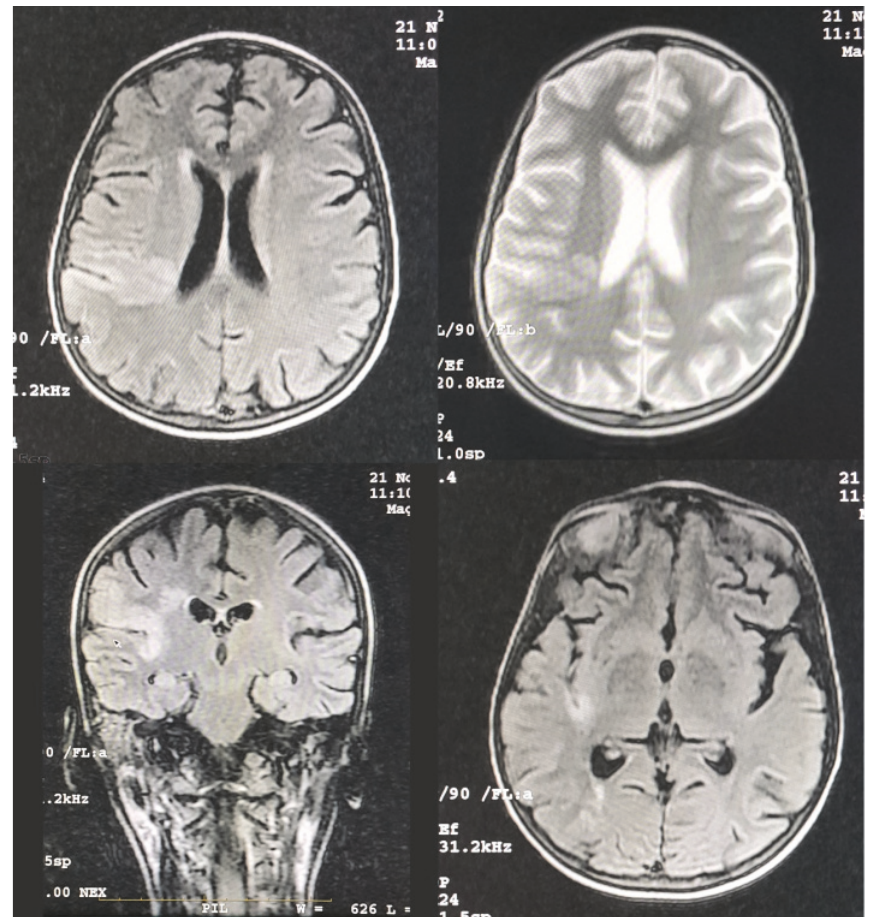
Figure 2: Patient MRI showing cortical and subcortical areas in the right temporoparietal fossa with high signal on T2 and FALIR studies, in addition to isointense foci in the cortical and subcortical area in the posterior part of the parietal lobe extending deeply through the posterior horn of the right lateral ventricle on T1